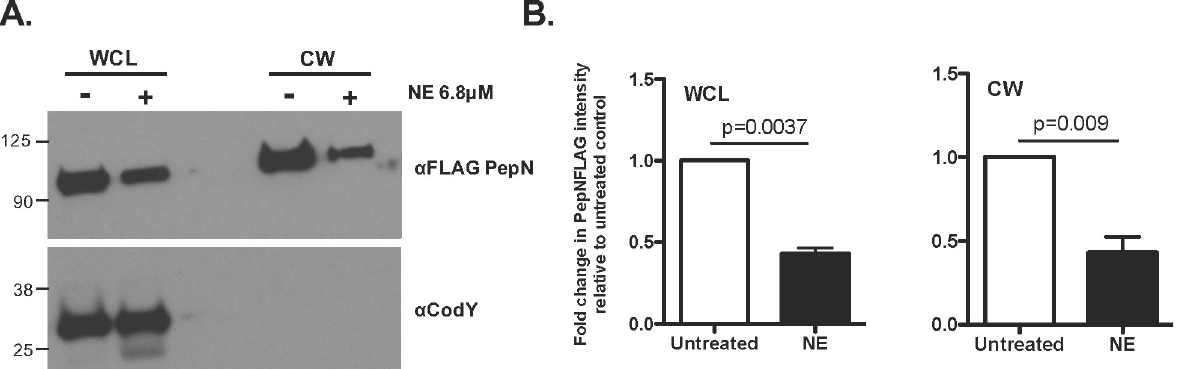
Fig 4. NE degrades PepN in intact Spn cells. Approximately 5 x 10 6 CFU of the PepNFLAG strain were grown to early-log phase and were either left untreated or were exposed to 6.8 μ M NE. (A) Cells were fractionated to isolate the CW and samples were analyzed via Western blotting using anti-FLAG or anti-CodY (a cytoplasmic protein) antibodies. Data shown are from one Western blot representative of four independent experiments. ( B) Band intensity in CWL and CW samples were normalized to a blank lane, are expressed as fold change relative to the untreated control and were quantified using ImageStudioLite software. Data presented are the means ± SD from 4 independent experiments.